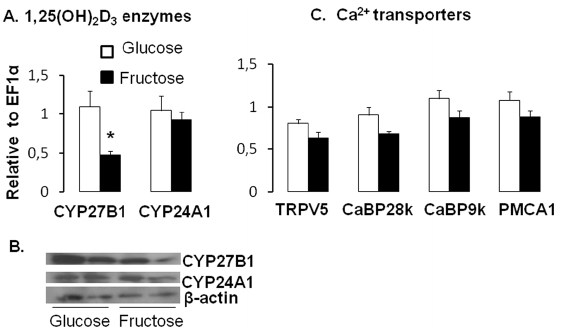
Figure 7. Effect of chronic fructose feeding on renal expression of 1,25(OH) 2 D 3 metabolizing enzymes and of Ca 2 + transporters. Rats were fed for three mo a normal Ca 2 + diet containing either 43% glucose or fructose. ( A ) mRNA expression level of renal 1,25(OH) 2 D 3 metabolic enzymes, CYP27B1 and CYP24A1 ( B ) The protein abundance of CYP27B1 and CYP24B1 using b -actin as a reference. ( C ) mRNA expression levels of renal TRPV6, CaBP28k, CaBP9k and PMCA1. All expression data were analyzed by real-time PCR using EF1 a as a reference and normalized relative to levels seen in rat fed glucose diet. Data are means 6 SEM ( n =6 per group). Differences ( P , 0.05) between means are indicated by asterisks. Chronic consumption of high fructose diets reduces mRNA and protein expression of CYP27B1.